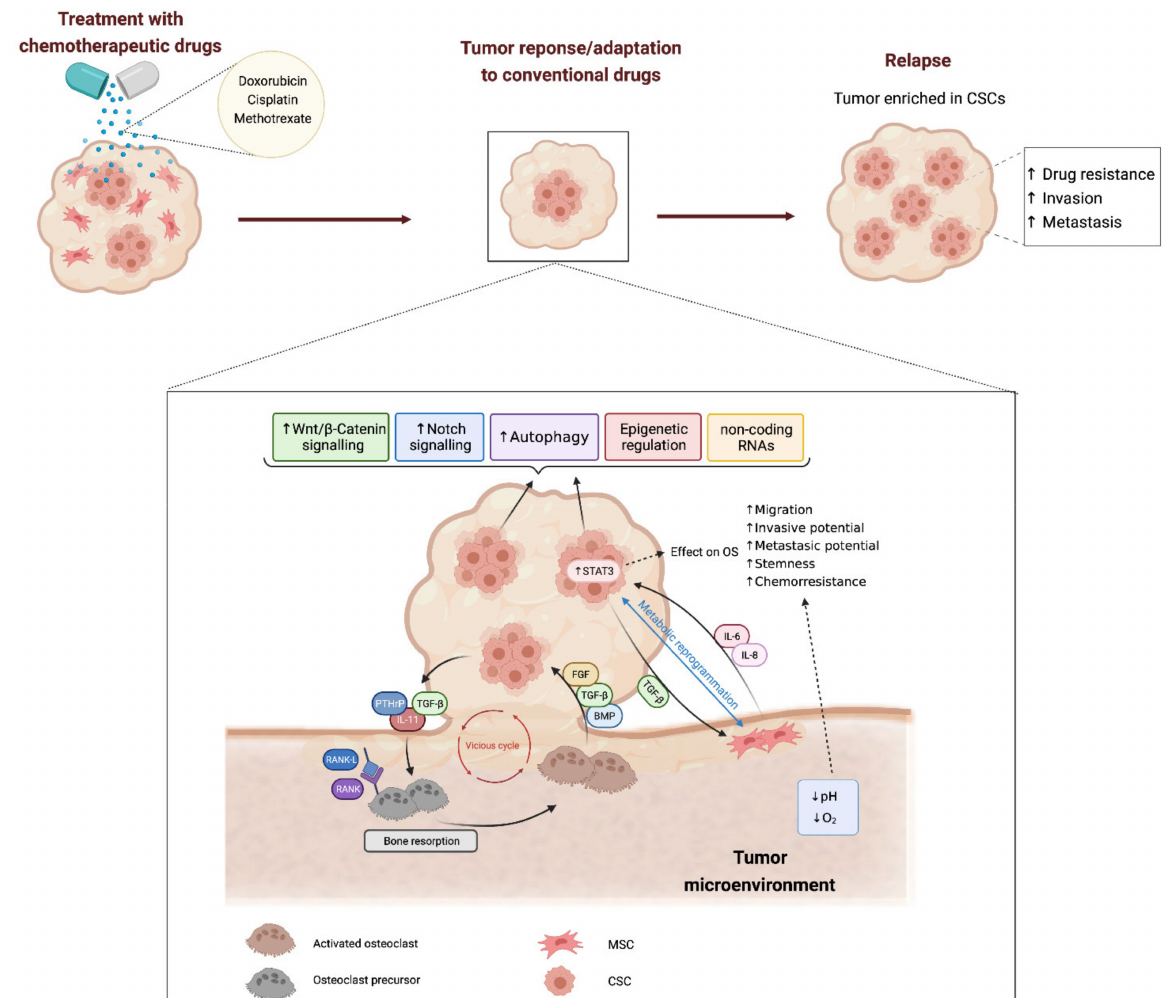
Figure 1. Mechanisms involved in Cancer Stem Cell-mediated drug-resistance in bone sarcomas. Tumor response to chemotherapeutic drugs is frequently characterized by the activation of stemness-related pathways such as WNT/ β -catenin and Notch signalling. Autophagy, epigenetic regulation and the expression of certain non-coding RNAs may also modulate CSC response to anti-cancer therapies. Within the bone microenvironment, the crosstalk between sarcoma cells and the cell types that regulate bone homeostasis may initiate a vicious circle resulting in a dysregulated bone lysis and the release of bone matrix growth factors (BMP, TGF- β or FGF) that promotes tumor growth and stemness. In addition, the crosstalk signalling between MSCs and tumor cells may also result in increased drug resistance and more aggressive phenotypes (higher invasive and metastatic potential) through the activation of pro-stemness factors, such as STAT3, or the metabolic reprogramming in sarcoma cells. Finally, hypoxic and/or acidic microenvironments may also contribute to CSC-mediated drug resistance in bone